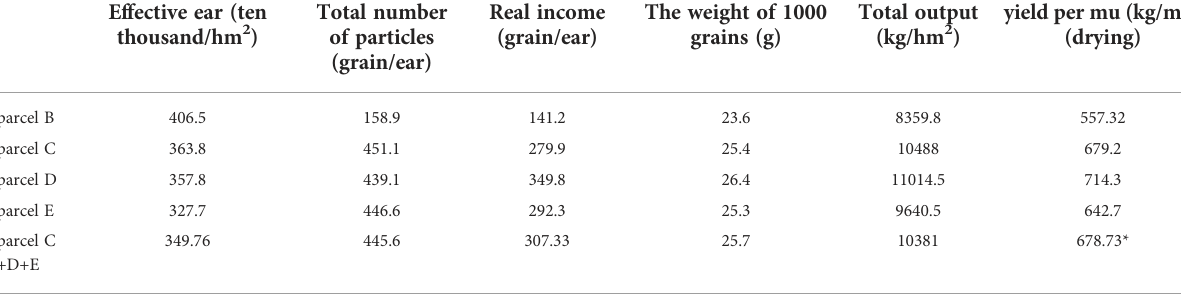
TABLE 2 Field investigation data of rice yield in parcel B and